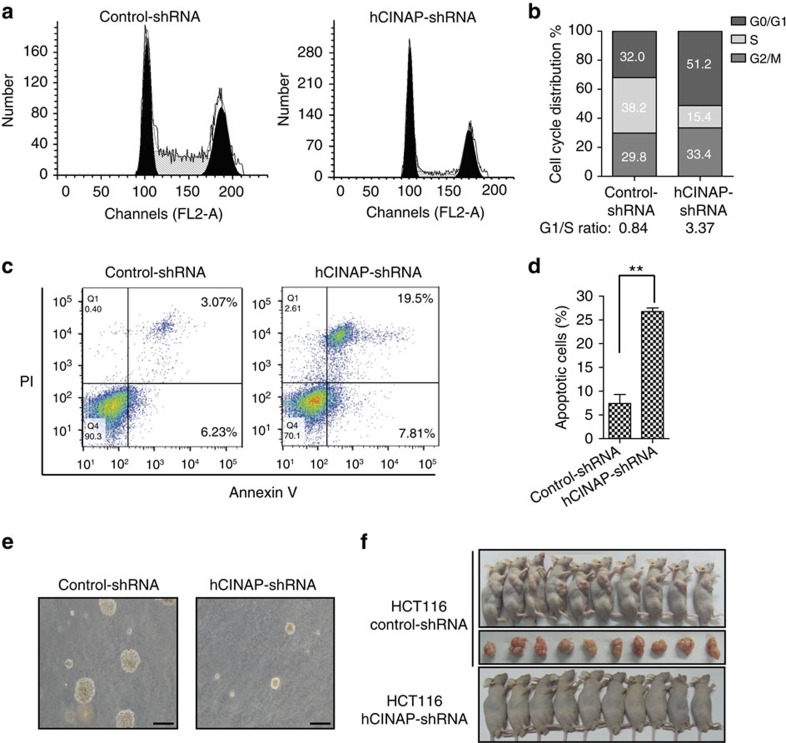
hCINAP depletion inhibits tumorigenesis.(a,b) hCINAP depletion caused cell cycle arrest at the G1 phase. HCT116 cells stably expressing control-shRNA or hCINAP-shRNA were subjected to FACS analysis. The percentage of cells in each phase was obtained from three independent experiments. (c,d) Apoptosis was measured with cells labelling with AnnexinV–fluorescein isothiocyanate (FITC) and propidium iodide and the signal was obtained using a BD FACS Caliber instrument. Results are presented as mean±s.d. **P<0.01 (Student's t-test). (e) HCT116 cells with stably expressed control-shRNA or hCINAP-shRNA were seeded in the soft agar and cultured for 2 weeks. Representative images of colonies formed by each type of cells were shown. Scale bar, 200 μm. (f) Tumour formation in nude mice (female, BALB/c, 5 weeks of age, 10 mice per group, randomly assigned) injected subcutaneously with HCT116 cells harbouring control-shRNA or hCINAP-shRNA. Tumours were isolated after 3 weeks. This experiment was carried out according to the ethical guidelines and approved by the Peking University Laboratory Animal Center.